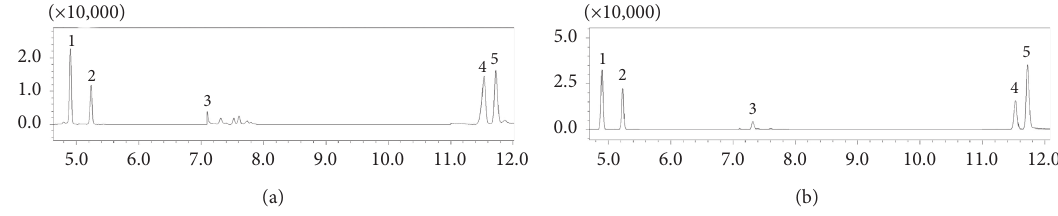
Figure 3: GC-MS under the SIM mode figure of extract of Xue-shuan-xin-mai-ning capsule on the vortex-assisted MSPD (a); mixed standard compounds (b). Peaks . 1: muscone; 2: ethyl palmitate; 3: ethyl oleate; 4: ethylparaben; 5: isopsoralen (IS). Table 1: Optimization of the results of the orthogonal experimental